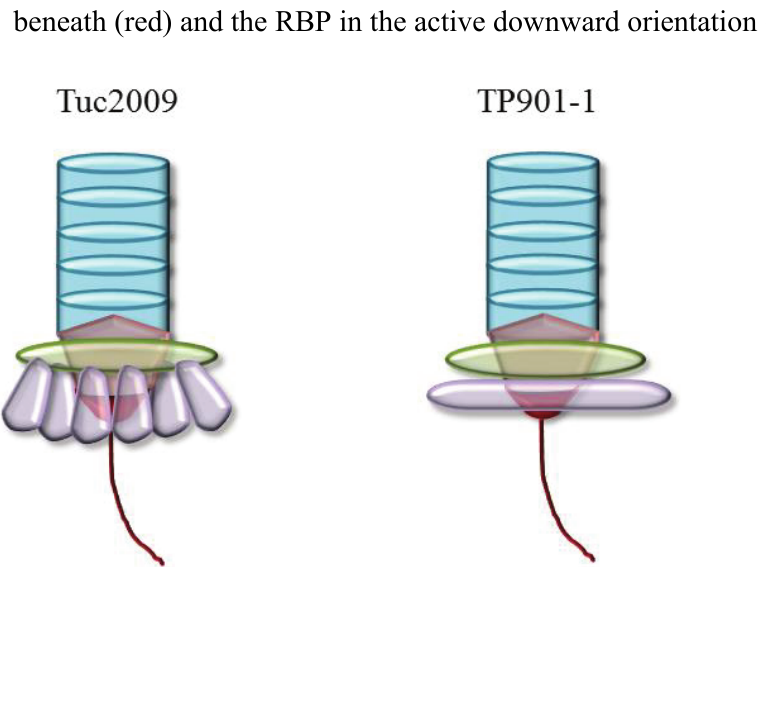
Figure 2. A schematic representation of the distal tail region of Tuc2009, TP901–1 and p2. The stacks of tail rings composed of the major tail protein (MTP) (blue) with the distal tail (Dit) protein (orange) beneath, upon which the baseplate components are hinged (green and purple). In the case of Tuc2009 the green area represents the upper baseplate disc (BppU and BppA) while the TP901–1 upper disc is composed of BppU only. The lower baseplate (BppL) is presented in purple with a disc representation for TP901–1 and a so-called “petticoat” representation for Tuc2009. The protrusion from the baseplates of TP901–1 and Tuc2009 represent the tail associated lysin (Tal) (red). The schematic of the baseplate region of p2 highlights ORF15 (orange) at the base of the tail with ORF16 beneath (red) and the RBP in the active downward orientation